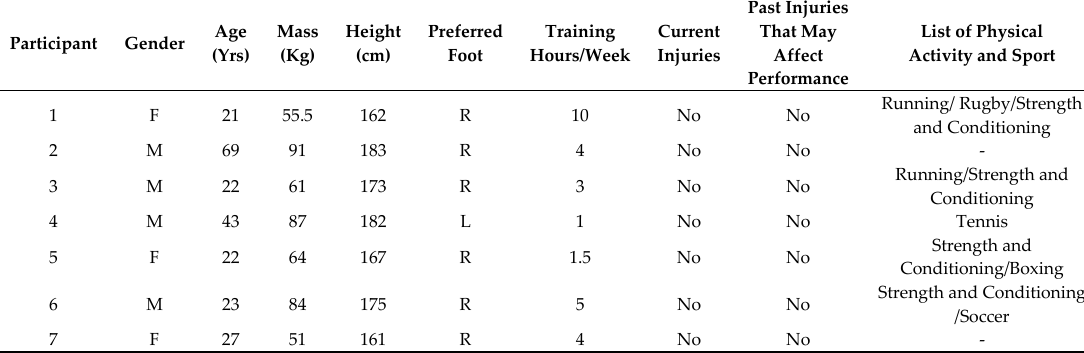
Table 1. Participant